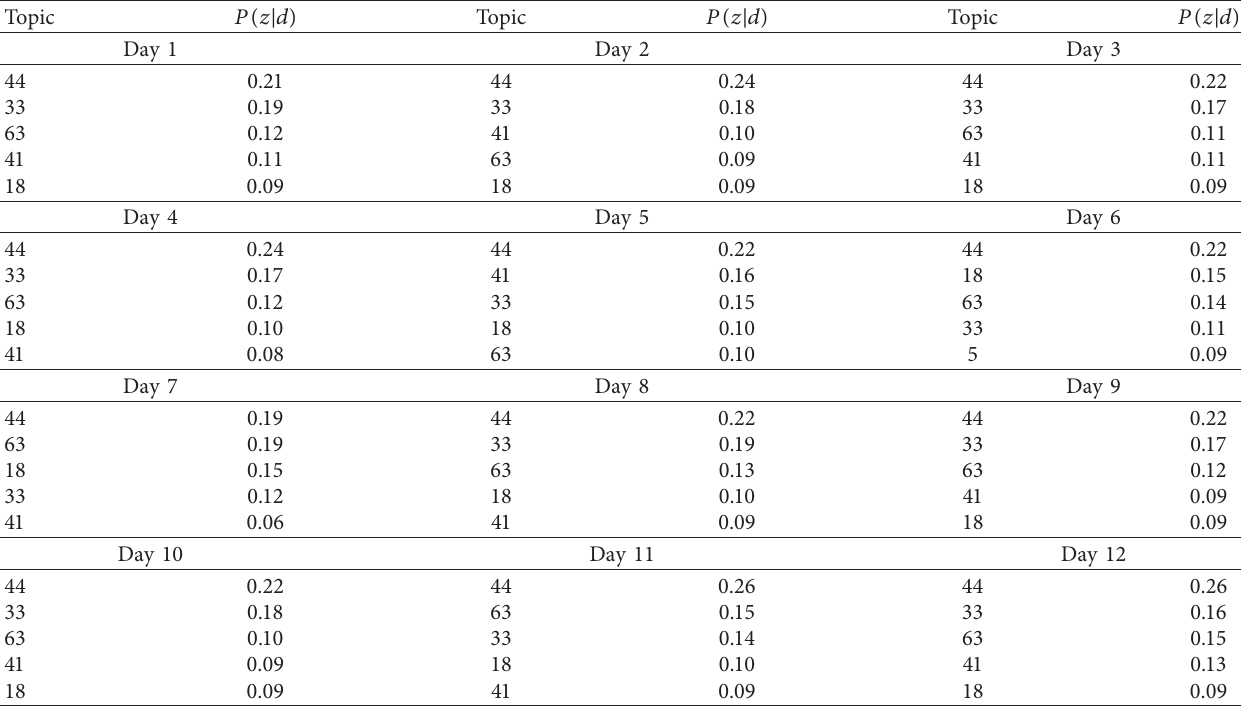
Table 5: Top topics for different